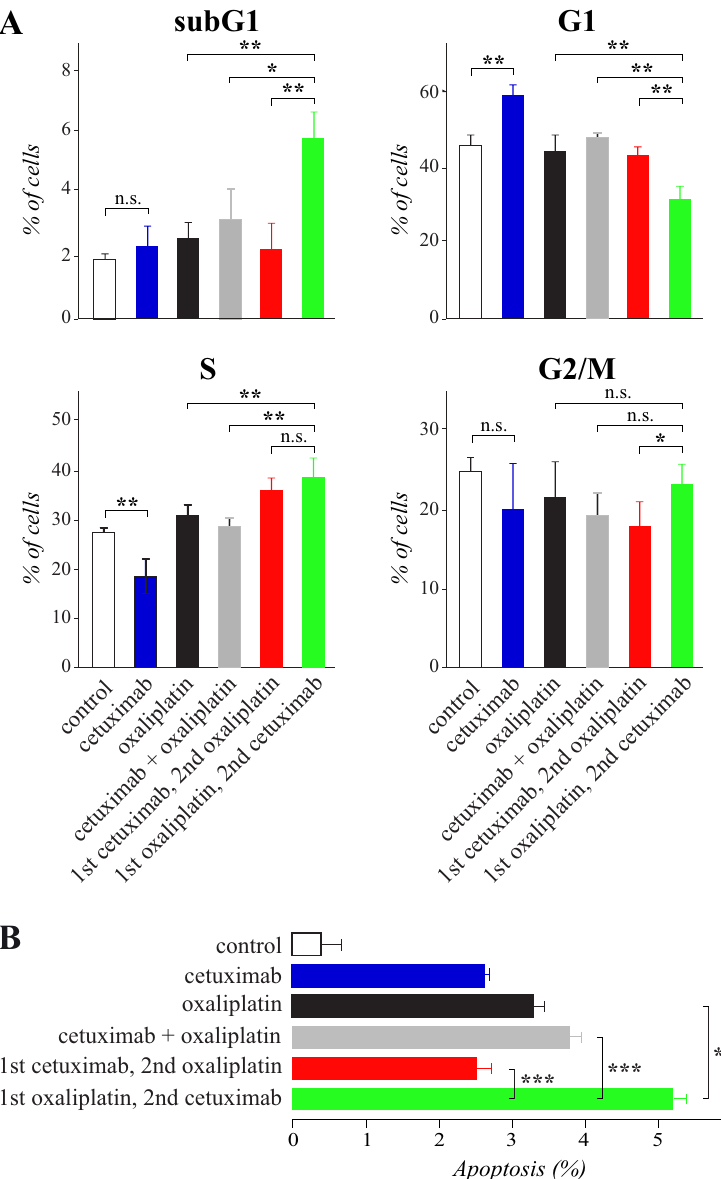
Figure 2. Sequential administration of cetuximab after oxaliplatin reduces G1 arrest and enhances apoptosis. Cell cycle ( A ) and apoptosis ( B ) analyses of HCA7 cells subjected to different regimens containing 10 μ g/ml cetuximab and/or 50 μ M oxaliplatin: (1) control medium for 24 hours (white), (2) cetuximab for 24 hours (blue), (3) oxaliplatin for 24 hours (black), (4) simultaneous combination of oxaliplatin and cetuximab for 24 hours (grey), or treated sequentially (5) first with cetuximab for 24 hours followed by oxaliplatin for 24 hours (red) or (6) first with oxaliplatin for 24 hours followed by cetuximab for 24 hours (green). Cell cycle was analyzed by PI staining ( A ) and apoptosis by annexin V staining ( B ). Mean + / − SD is